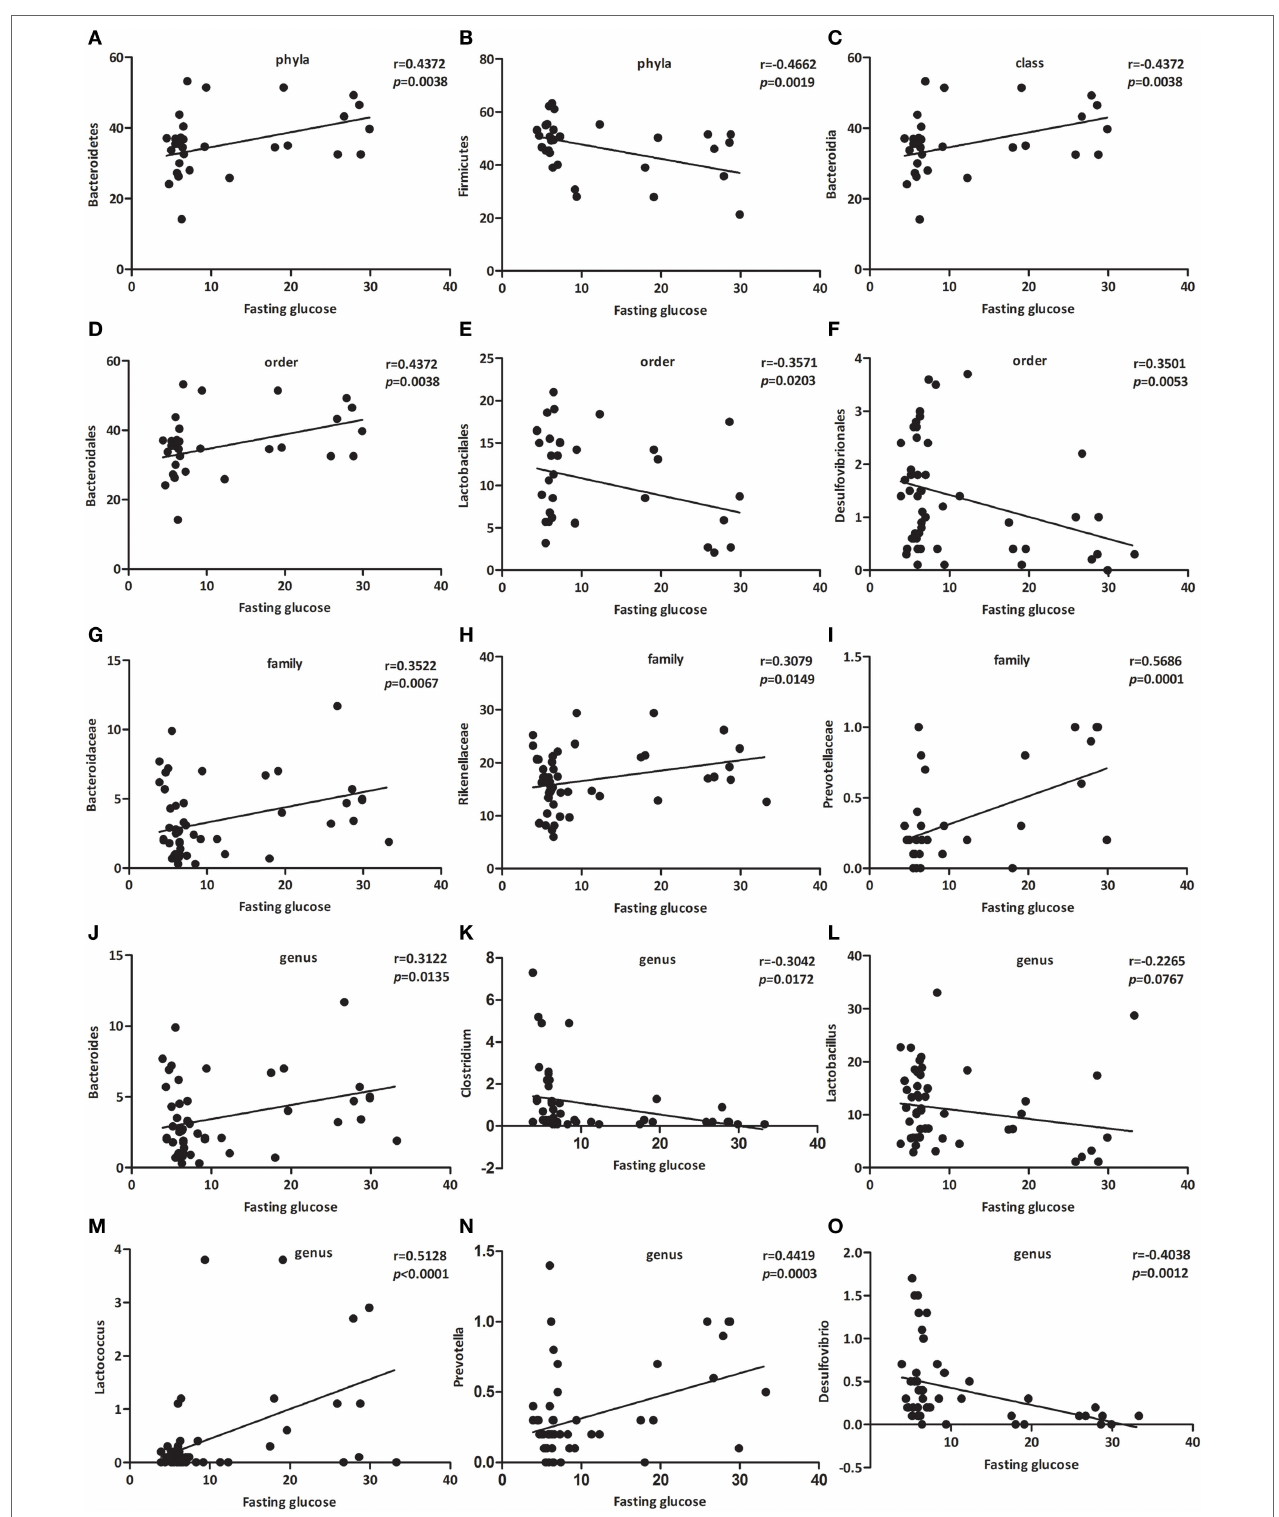
FigUre 4 | Specific bacterial groups in the gut correlate with fasting glucose. Correlation analyses between fasting glucose and the relative abundance (%) of (a) Bacteroidetes, (B) Firmicutes, (c) Bacteroidia, (D) Bacteroidales, (e) Lactobacilales, (F) Desulfovibrionales, (g) Bacteroidaceae, (h) Rikenellaceae, (i) Prevotellaceae, (J) Bacteroides, (K) Clostridium , (l) Lactobacillus , (M) Lactococcus , (n) Prevotella , (O) Desulfovibrio . n = 42–62. *, **, *** p < 0.05, p < 0.01, p < 0.001 vs NOD control mice by t